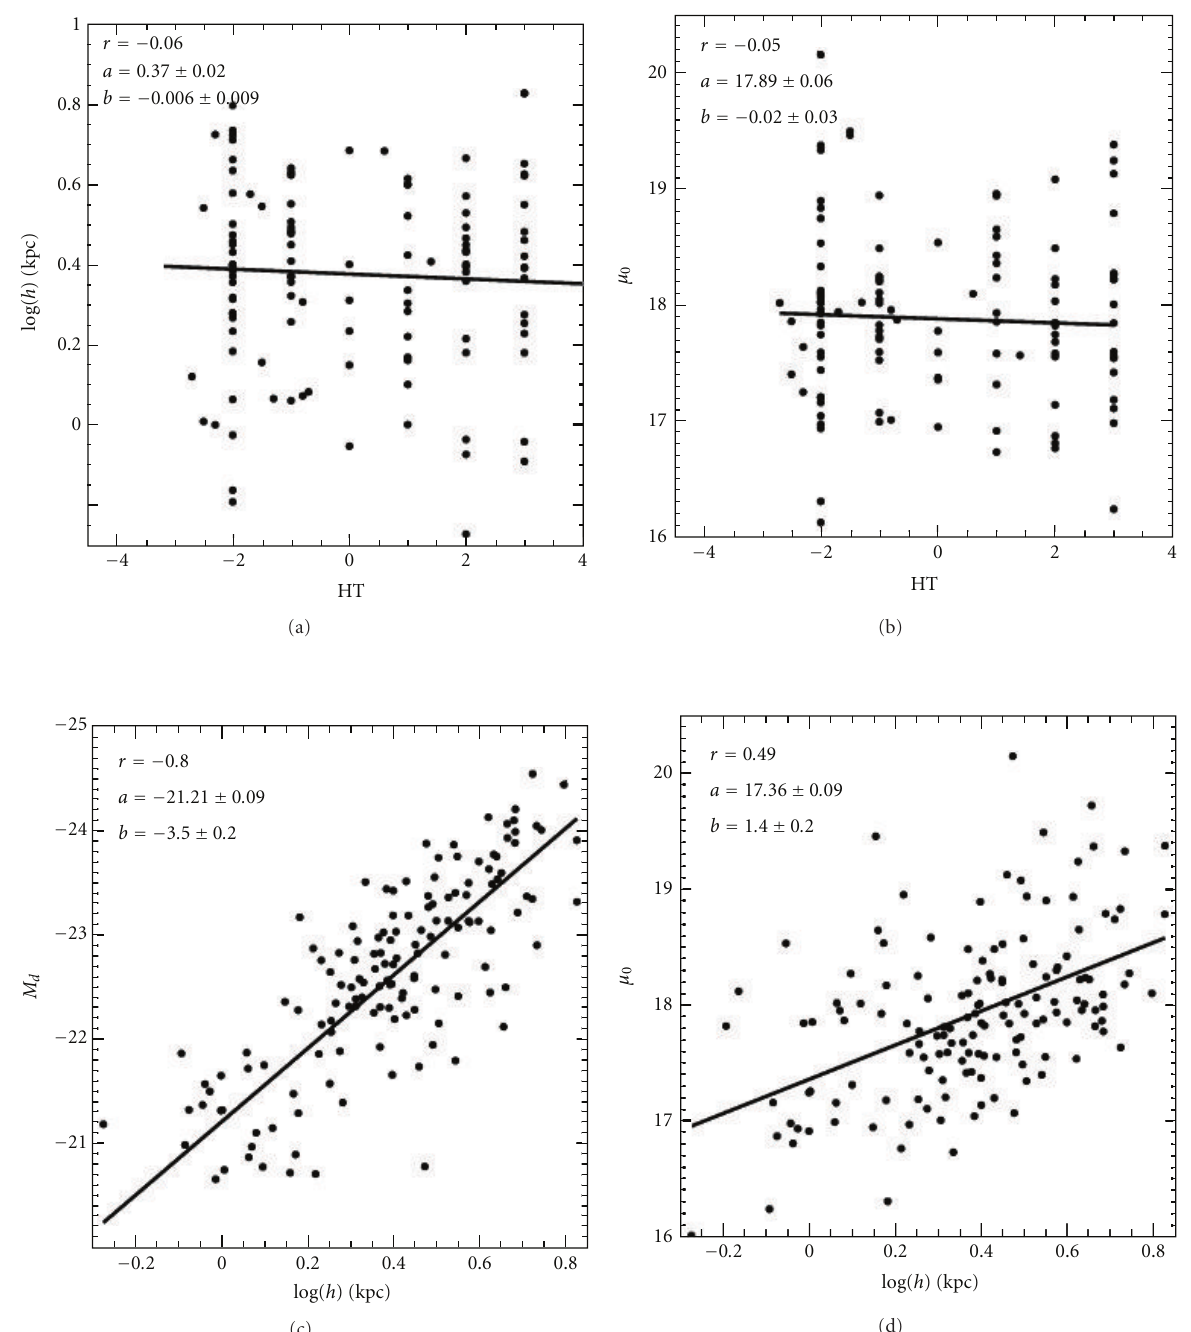
Figure 11: Correlations between the disc parameters for a sample of lenticulars and early-type spirals. Correlation between the Hubble type and disc scale length (a) and the central surface brightness (b). Correlations between the disc scale length and the absolute magnitude of the disc (c) and the central surface brightness (d). The full line represents the best linear fit ( y = a + bx ). The Pearson correlation coe ffi cient ( r ) is also indicated. See [103] for more